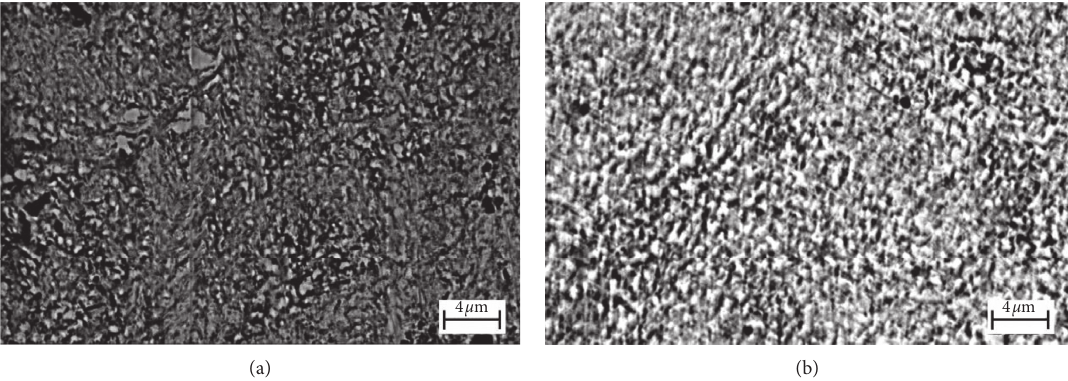
Figure 8: Structure of 40kh steel with optimal parameters after VCH at (a) 100 μ m depth and (b) the initial lattice structure.